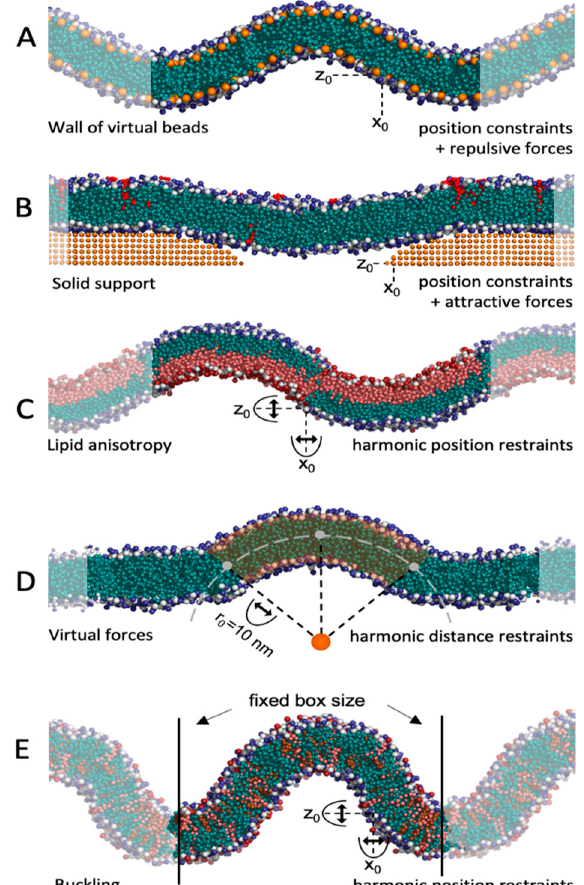
Figure 4. Methods for setting up and maintaining curvature. ( A ) Scaffolding approach, employing a ‘wall’ of virtual beads (orange) that sustain membrane curvature by repulsive forces between the beads and lipid tails. Pure POPC membrane, set-up using TS2CGv1.1 [43]. The semi-transparent membrane is the periodic extension of the simulated box. ( B ) Scaffolding approach, where the membrane is attracted to a solid support with a hole. A cross-section through the hole is shown. Membrane of DOPC (blue) and POPI P2 (red). Set-up using the protocol in Ref. [50]. ( C ) Lipid asymmetry-induced curvature. The anisotropy is maintained by virtual repulsive forces between POPC (blue) and POPS (red). Membrane fluctuations are suppressed by harmonic position restraints. Set up following Ref. [54]. ( D ) Virtual forces can generate and maintain a membrane curvature defined by a set of collective variables. Here, the virtual forces are harmonic restraints on the distance between a virtual bead (orange) and a section (yellow) of a POPC membrane. Set-up using EnCurv [48]. ( E ) The membrane is compressed in one direction (buckling) and then the box dimensions are fixed. Membrane fluctuations are avoided by position restraints. Mixed membrane of POPC (blue), POPS (red) and cholesterol (brown). Set up using Refs. [55,56]. (All original figures, generated for this review).